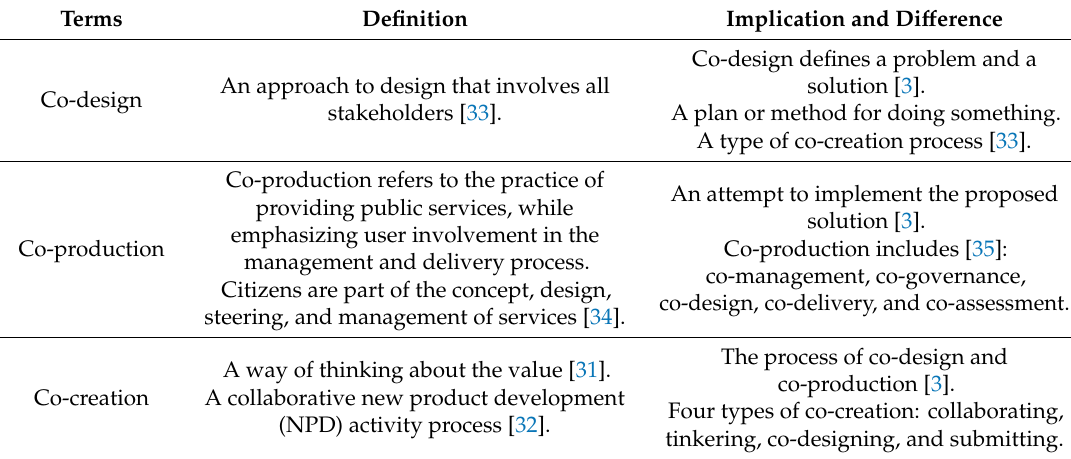
Table 1. Summarize the interpretation of the terms “co-design”, “co-production”, “and co-creation” in the